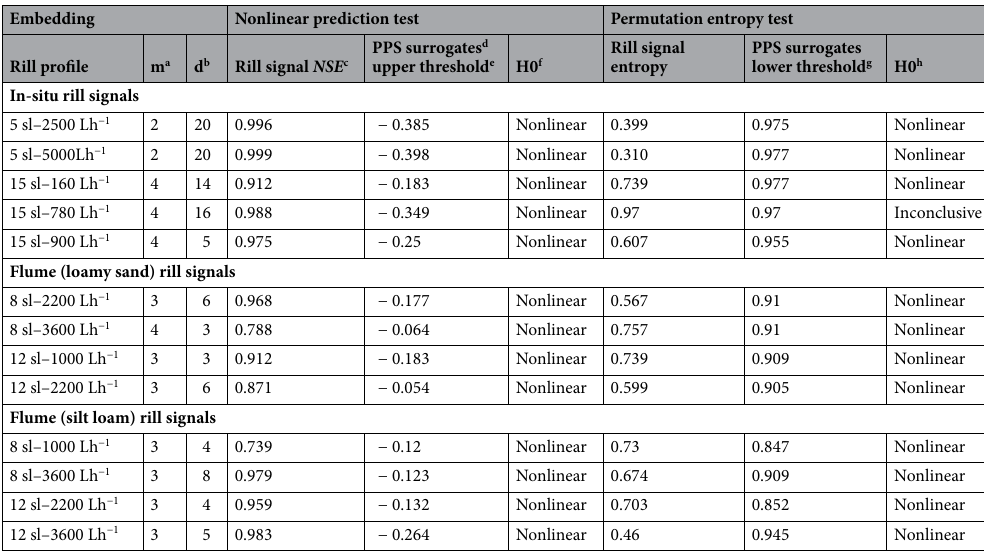
Table 2. Surrogate data results. a Embedding dimension; b embedding delay; c Nash Sutcliffe Efficiency ( NSE =